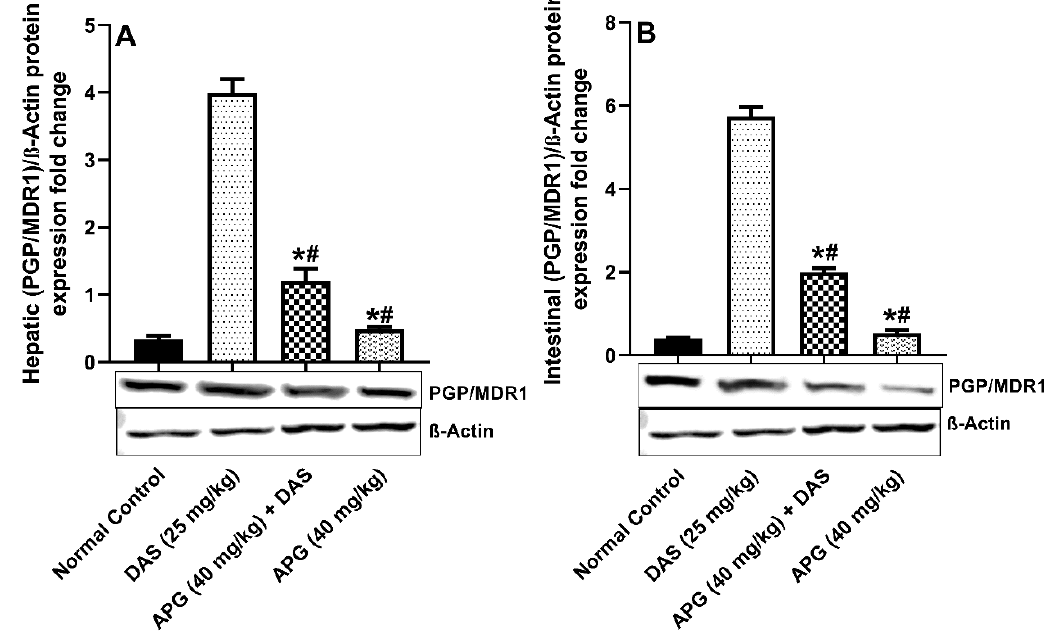
Figure 4. Hepatic ( A ) and intestinal ( B ) PGP/MDR1 protein expression in rats after DAS administra- tion with or without APG pretreatment. All results are presented as the average ± SD. * p < 0.05 (Normal control); # p < 0.05 (DAS).